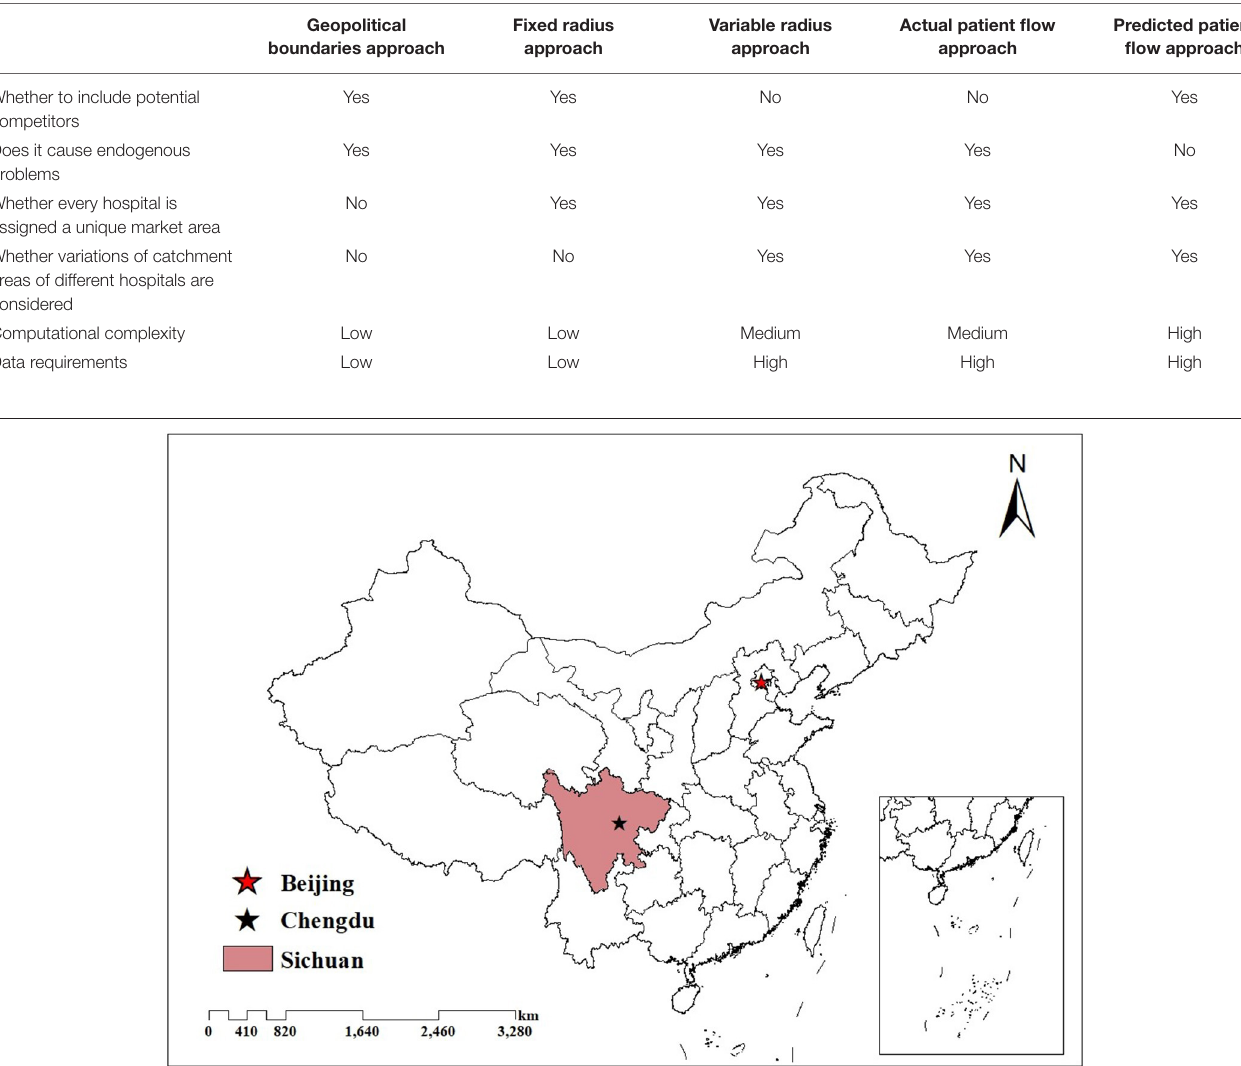
TABLE 1 | The comparison between different hospital market definition approaches.